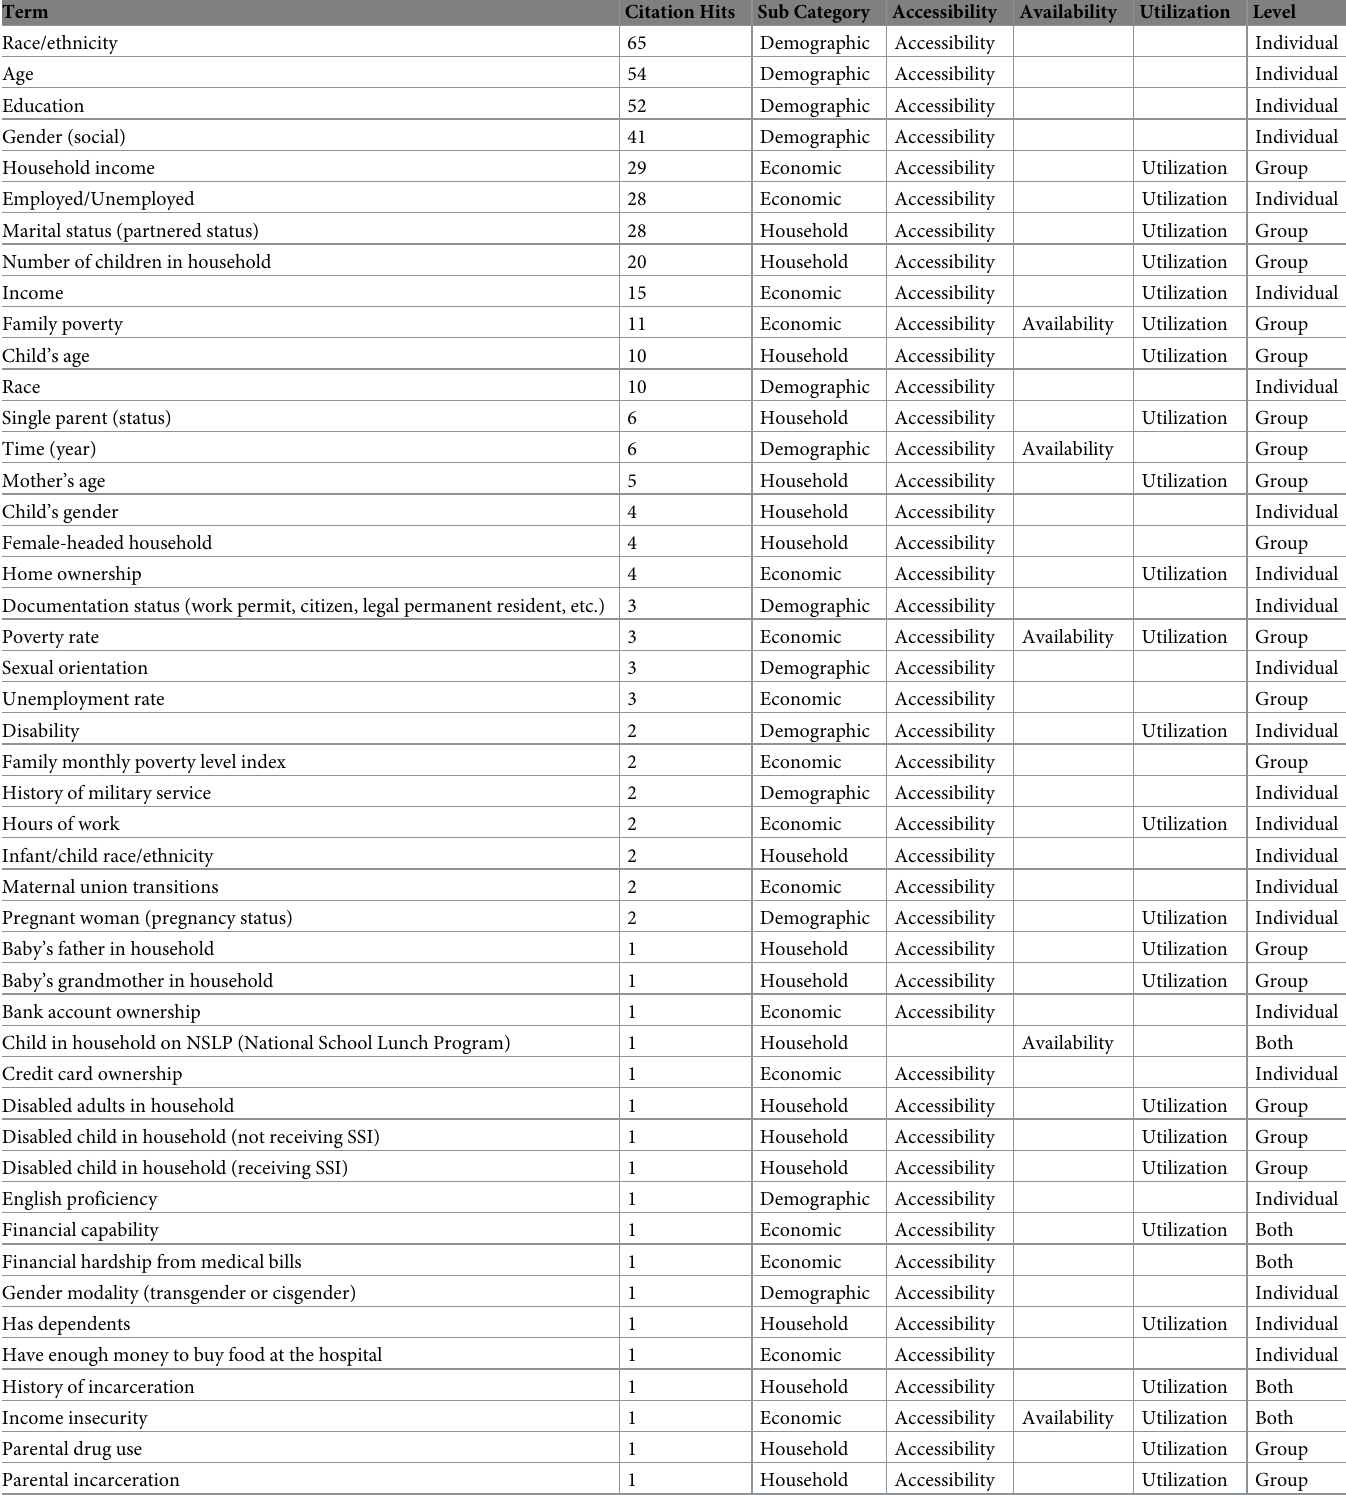
Table 2. Demographic risk factors mapped to the dimensions of food